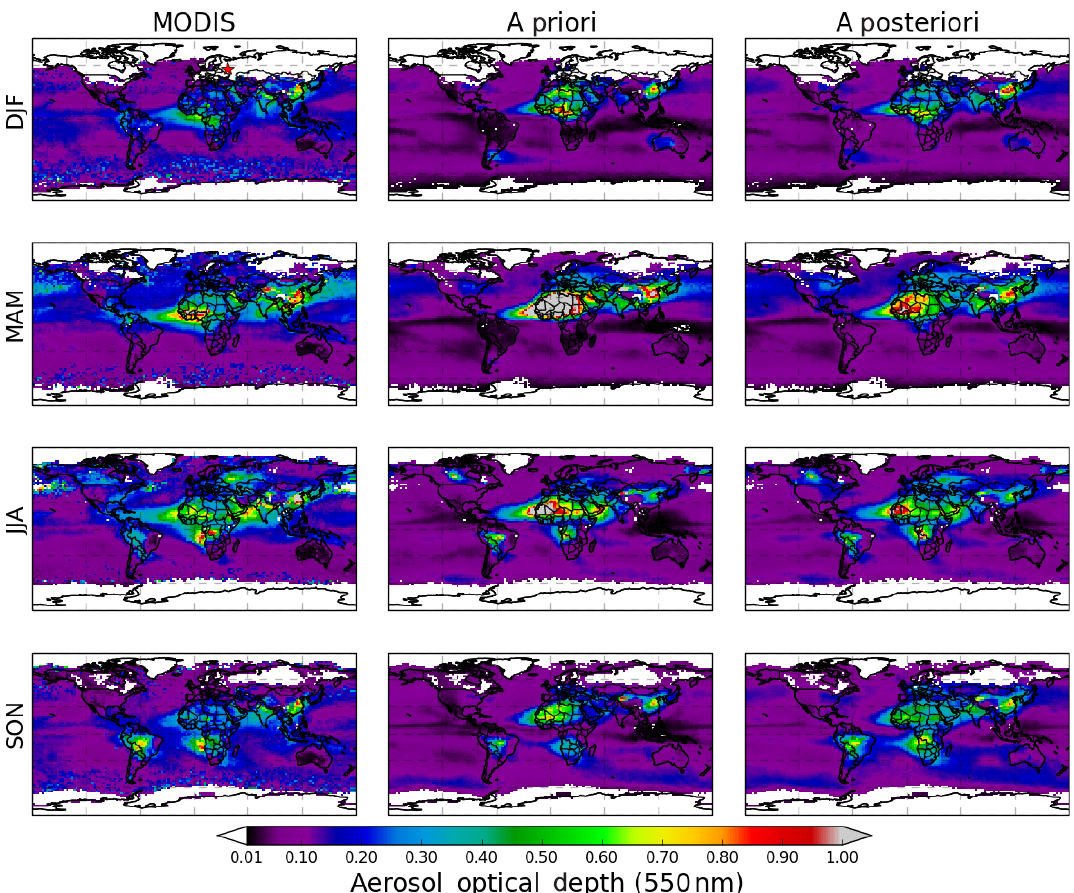
Figure 9. Comparison of a priori and a posteriori GEOS-Chem simulated seasonal AOD at 550nm with MODIS C6 Dark Target and Deep Blue merged